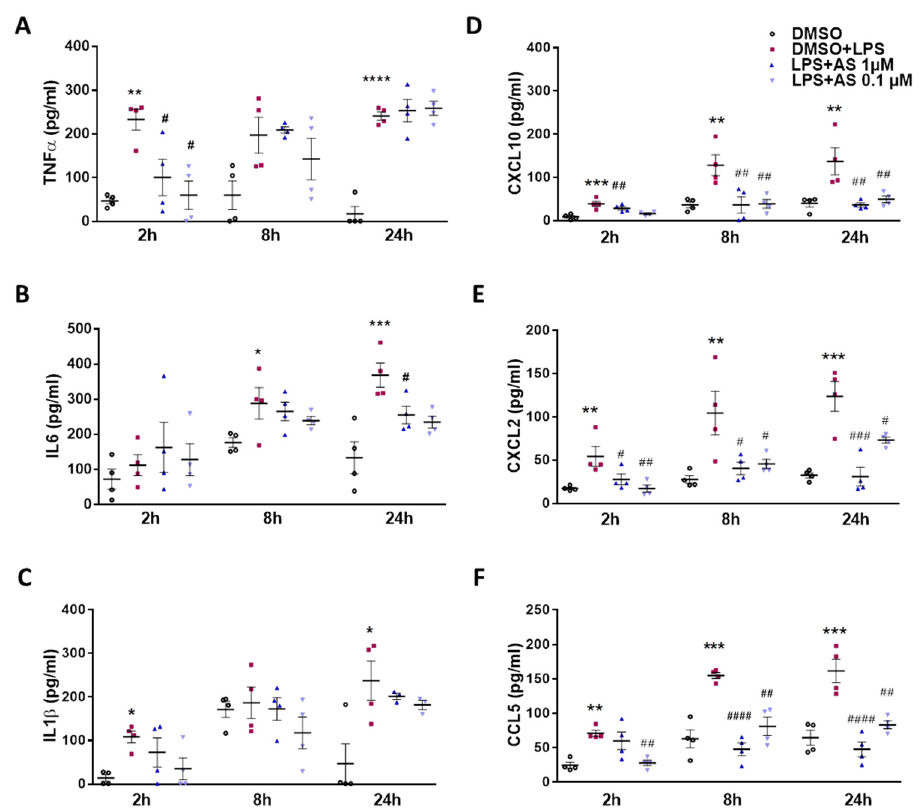
Figure 6. Inhibition of LPA5 by AS2717638 attenuates LPS-induced secretion of cyto-/chemokines in BV-2 microglia. Cells were treated with DMSO control, LPS plus DMSO in the absence or presence of AS2717638 (‘AS’; 1 and 0.1 µ M) for the indicated times. Supernatants were collected. ( A–F ) Concentration of cytokines TNF α , IL6, and IL-1 β and chemokines CXCL10, CXCL2, and CCL5 were quantified by ELISA. Values are expressed as mean ± SEM of three independent experiments. (* p < 0.05, ** p < 0.01, *** p < 0.001, **** p < 0.0001 compared to DMSO control; # p < 0.05, ## p < 0.01, ### p < 0.001, #### p < 0.0001 compared to LPS-treated cells; one-way ANOVA with Bonferroni correction).